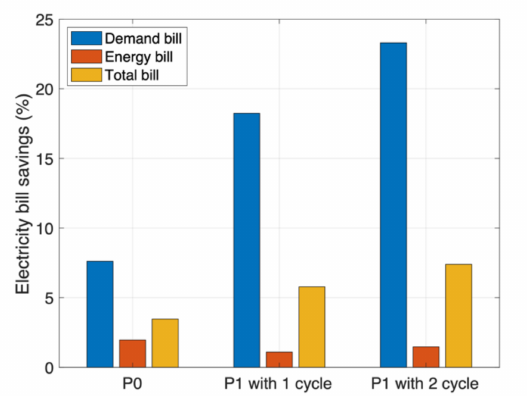
Figure 4. Savings on electricity bills of the participants when the implemented VESS capacity is 150 kWh.